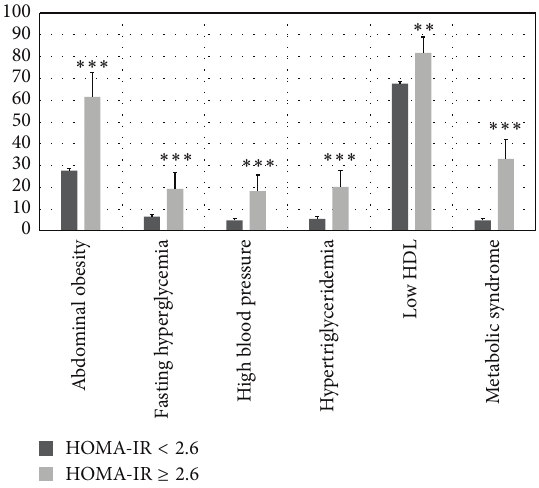
Figure 2: Prevalence rates of cardiovascular and metabolic risk factors by HOMA-IR. Error bars are 95% CI. Statistical significant difference by Pearson’s Chi2. Significance level: ∗ 𝑃 < 0.05 ; ∗∗ 𝑃 < 0.01 ; ∗∗∗ 𝑃 <